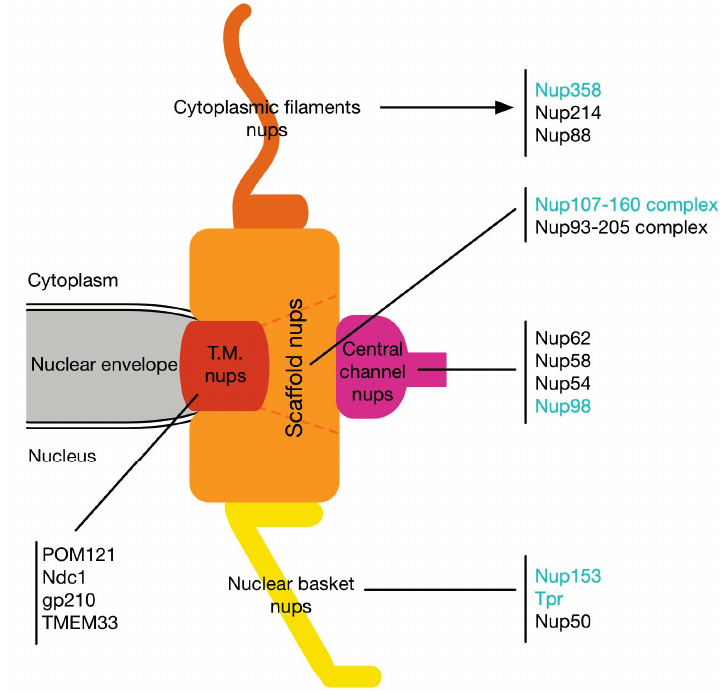
Figure 1. Schematic representation of nuclear pore complexes and the position of nucleoporins. The localization of the different nucleoporin subgroups is represented: Transmembrane nucleoporins (T.M. nups; red ), scaffold nucleoporins ( orange ), central channel nucleoporins ( purple ), cytoplasmic filaments nucleoporins ( light brown ), and the nuclear basket nucleoporins ( yellow ). The nucleoporins highlighted in cyan refer to the nucleoporins implicated in the different mitotic processes discussed in this